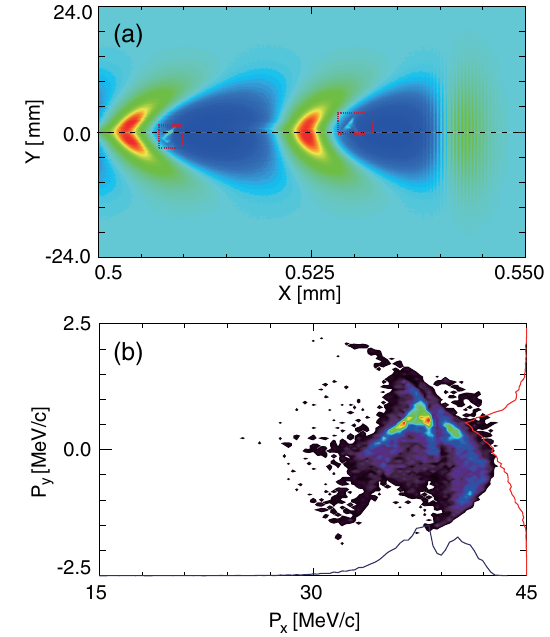
FIG. 4. (a) Plasma density when the drive pulse has propagated 0.55 mm. The black dashed line shows the bubble axis. Injected beams labeled in the dashed square can be seen in the first and second buckets of the wake. The trapped electron bunch centroids are off axis. (b) Distributions of the trapped electrons in P x - P y space. The right curve shows the transverse momentum spread and the bottom blue curve shows the longitudinal momentum spread (at 0.55